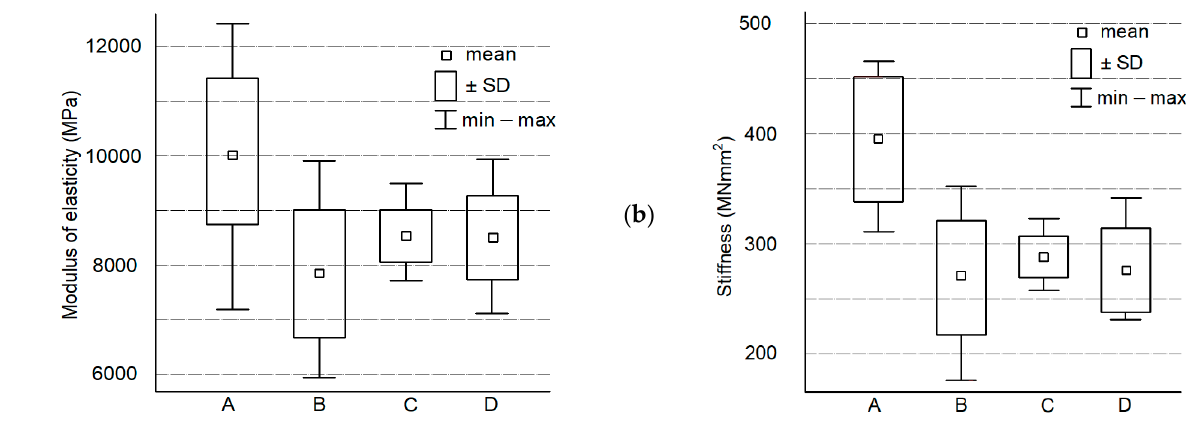
Figure 5. Results of static bending after air conditioning under conditions of 22 °C and 50% air humidity: ( a ) MOE; ( b ) stiffness.